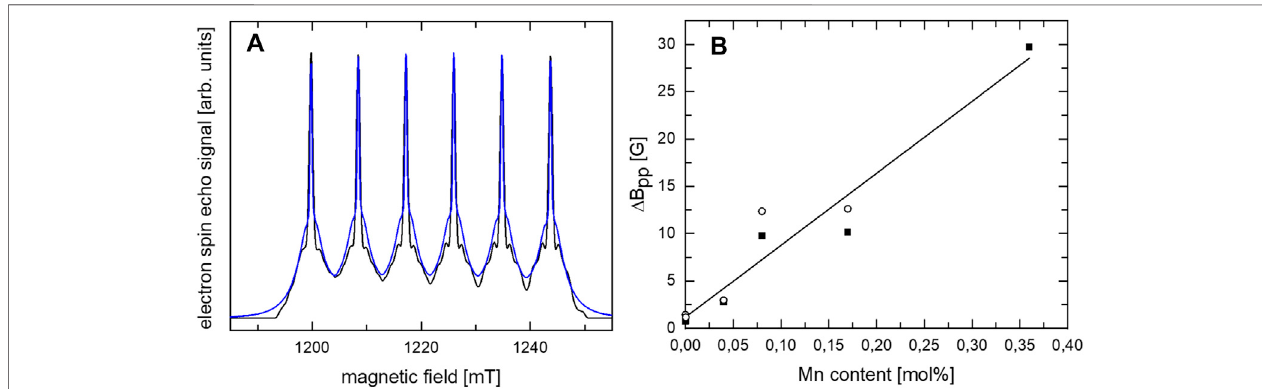
FIGURE 6 | (A) 34 GHz FSE spectra of CaO with 0.04 mol% Mn (blue) and simulation (black) assuming a cubic symmetry. (B) Dependence of Δ B pp linewidth in 34 GHz (open circles) and 9.8 GHz (solid squares) cw EPR measurements at room temperature on the Mn content.